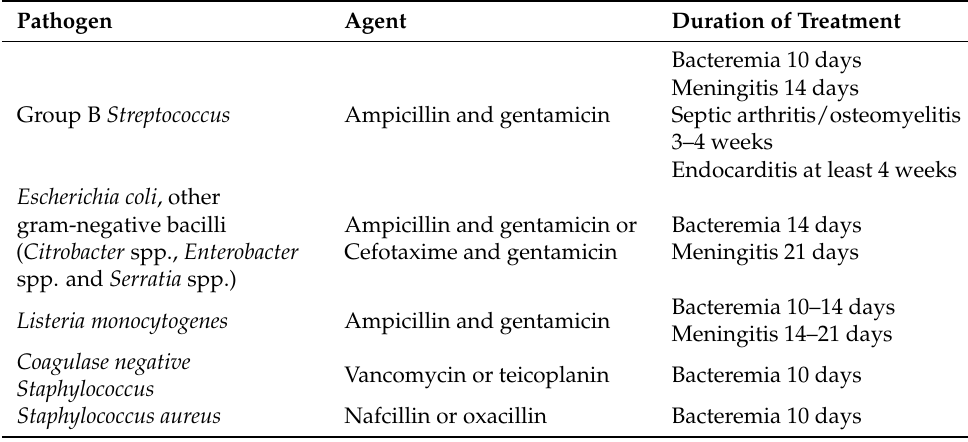
Table 1. Targeted antimicrobial therapy on neonatal